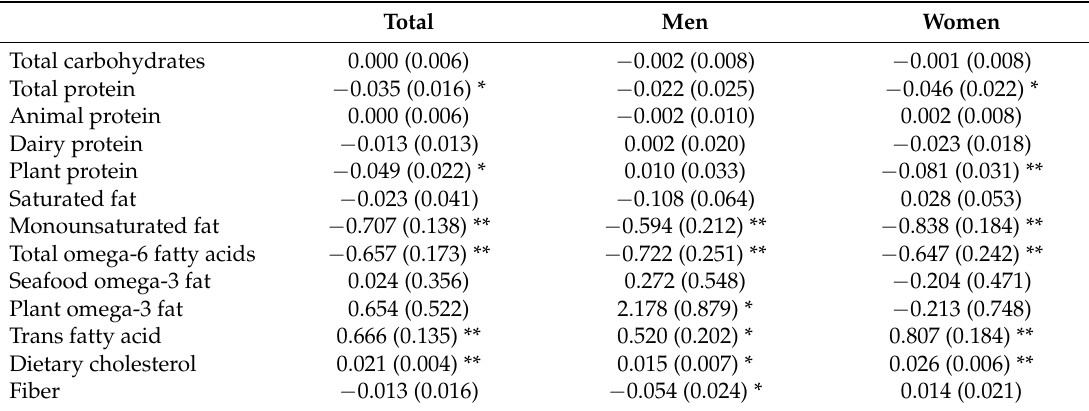
Table 6. Linear association between macronutrient intake and BMI levels in the study participants of the MEAL study ( n = 1838). * denotes p < 0.05, ** denotes p < 0.001.